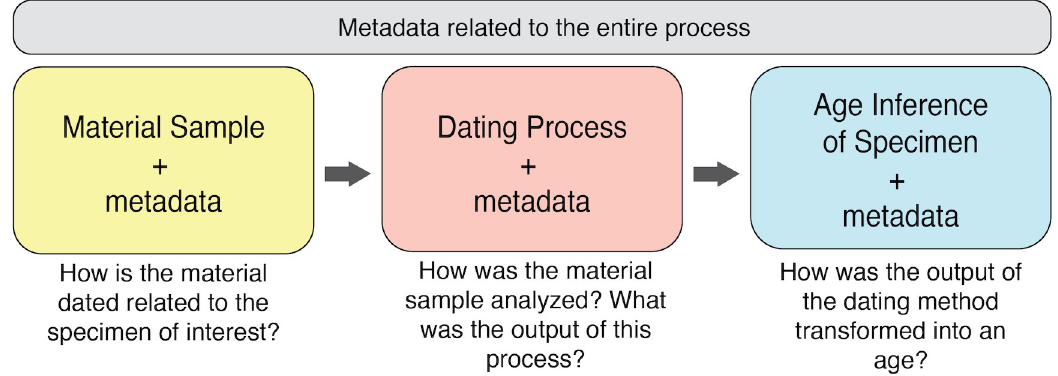
Fig 1. The conceptual layout of the Chronometric Age extension with data representing different parts of the dating process.